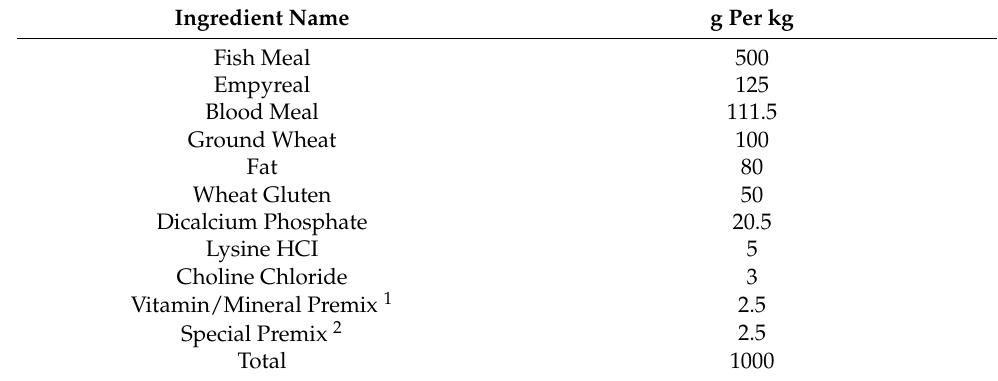
Table 1. Complete ingredient list and inclusion by mass for experimental diets fed to young-of-the year striped bass ( Morone saxatilis ) during the laboratory feeding period (20 September–8 November 2016) prior to transfer to freshwater